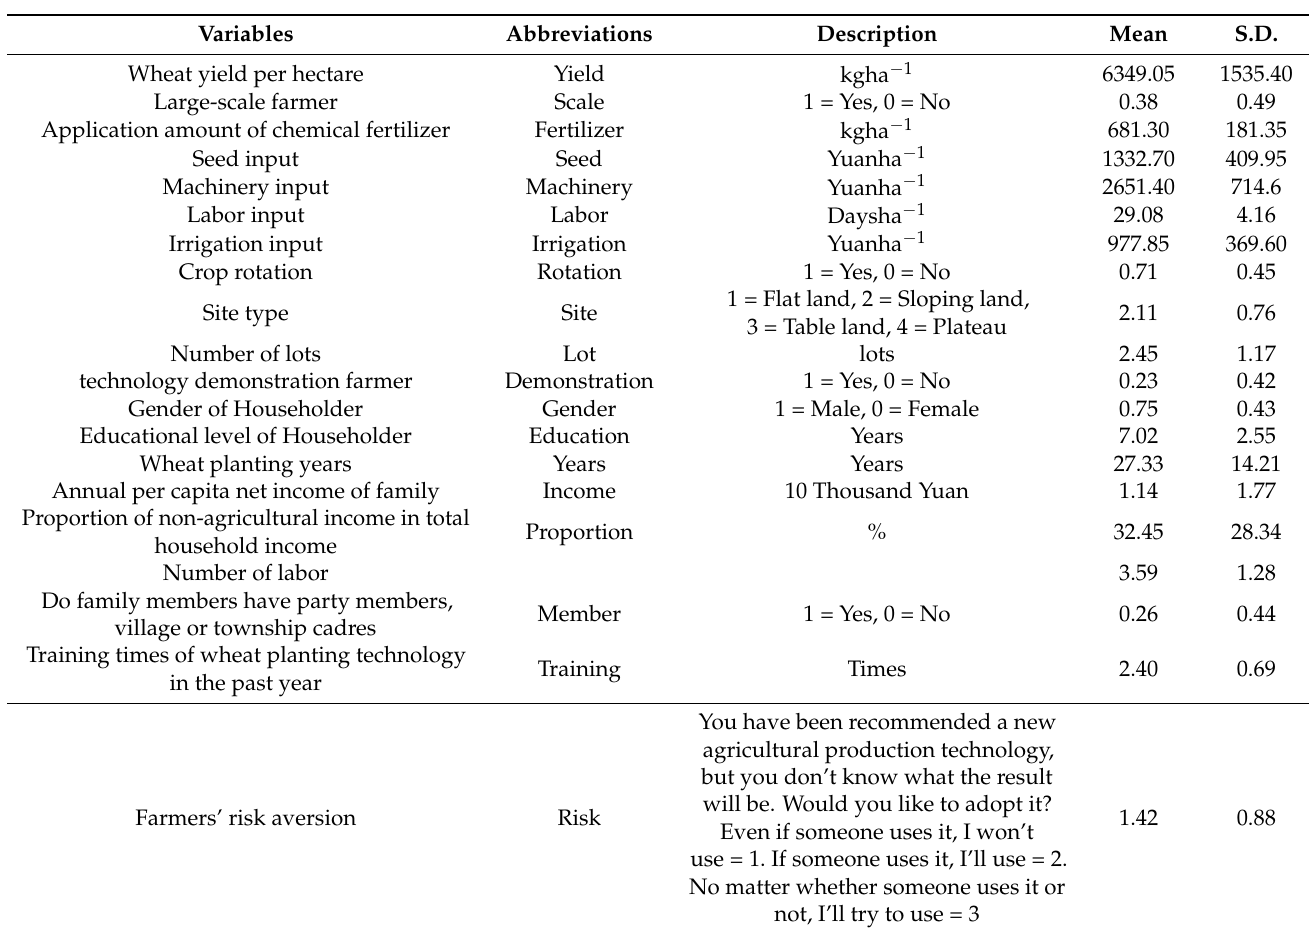
Table 2. Variable description and statistical